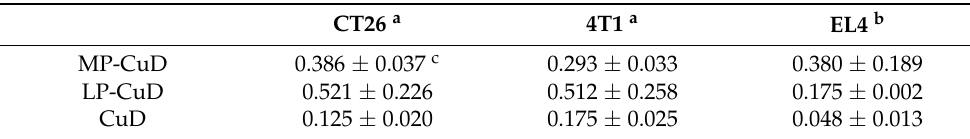
Table 2. Cytostatic/cytotoxic activity of the polymer conjugates carrying CuD in selected murine tumor cells.